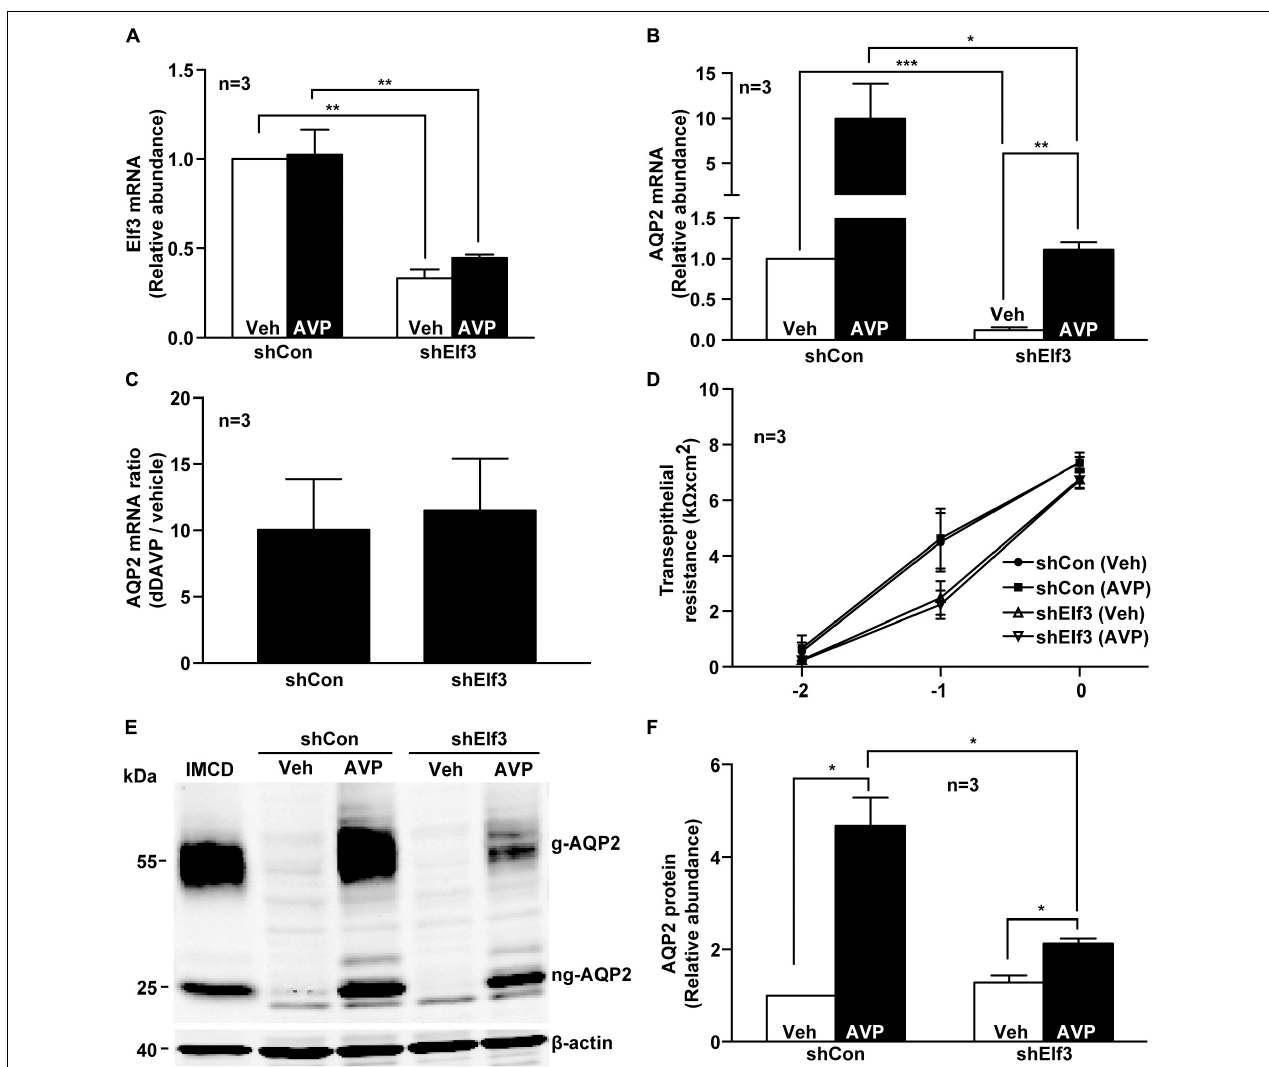
FIGURE 2 | Elf3 knockdown reduced basal and vasopressin-induced AQP2 gene expression in the mpkCCD cells. (A) Elf3 and (B) AQP2 mRNA levels in the control (shCon) or stable Elf3 knockdown cells in response to vehicle (Veh) or 0.1 nM dDAVP (AVP) stimulation for 8 h. Values are means ± SE, adjusted for loading (RPLP0 mRNA levels) and normalized against the values of the control cells under the vehicle conditions. Asterisk indicates significant difference ( ∗ p < 0.05; ∗∗ p < 0.01; and ∗∗∗ p < 0.001, t -test). (C) AQP2 mRNA ratios summarized from the experiments shown in (B) . (D) Transepithelial resistance of the control and stable Elf3 knockdown cells grown on Transwell prior to the experiments. (E,F) Representative and summary of immunoblotting for AQP2 protein in the control and stable Elf3 knockdown cells in response to vehicle or dDAVP. Values are means ± SE, adjusted for loading ( β -actin staining) and normalized against values in the control cells under the vehicle conditions. Cell lysate from hamster inner medullary collecting duct (IMCD) serves as a positive control. β -actin serves as a loading